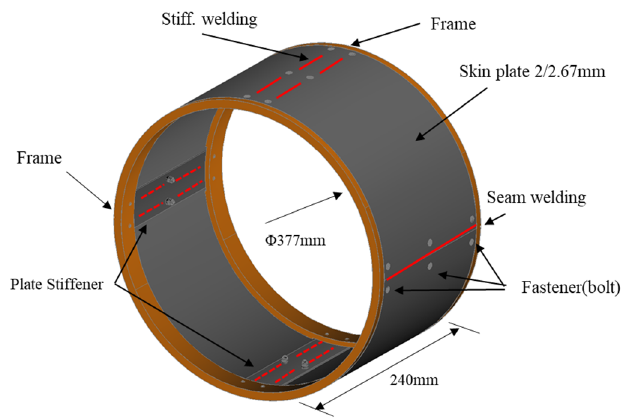
Figure 6. Specimen used in experiment and analysis.